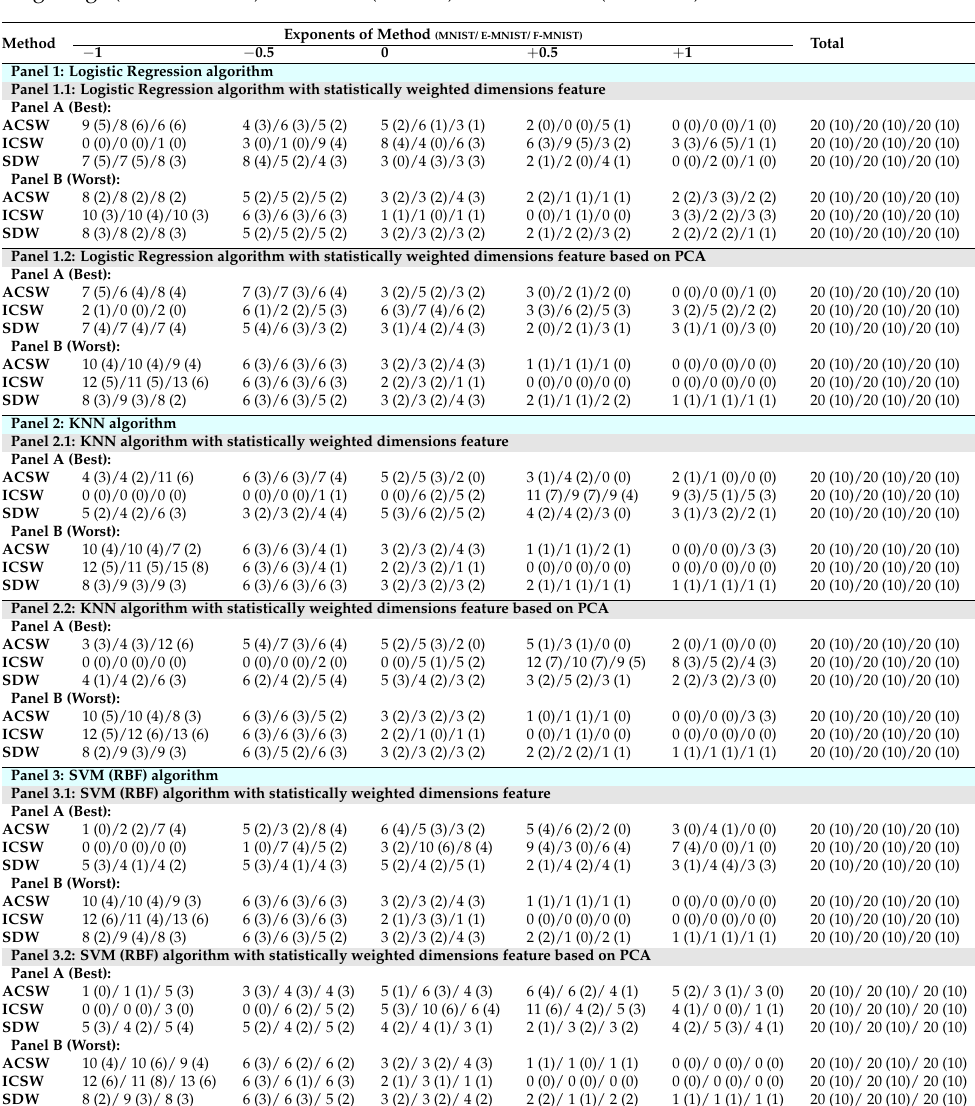
Panel3.1: SVM(RBF)algorithmwithstatisticallyweighteddimensionsfeature PanelA(Best):